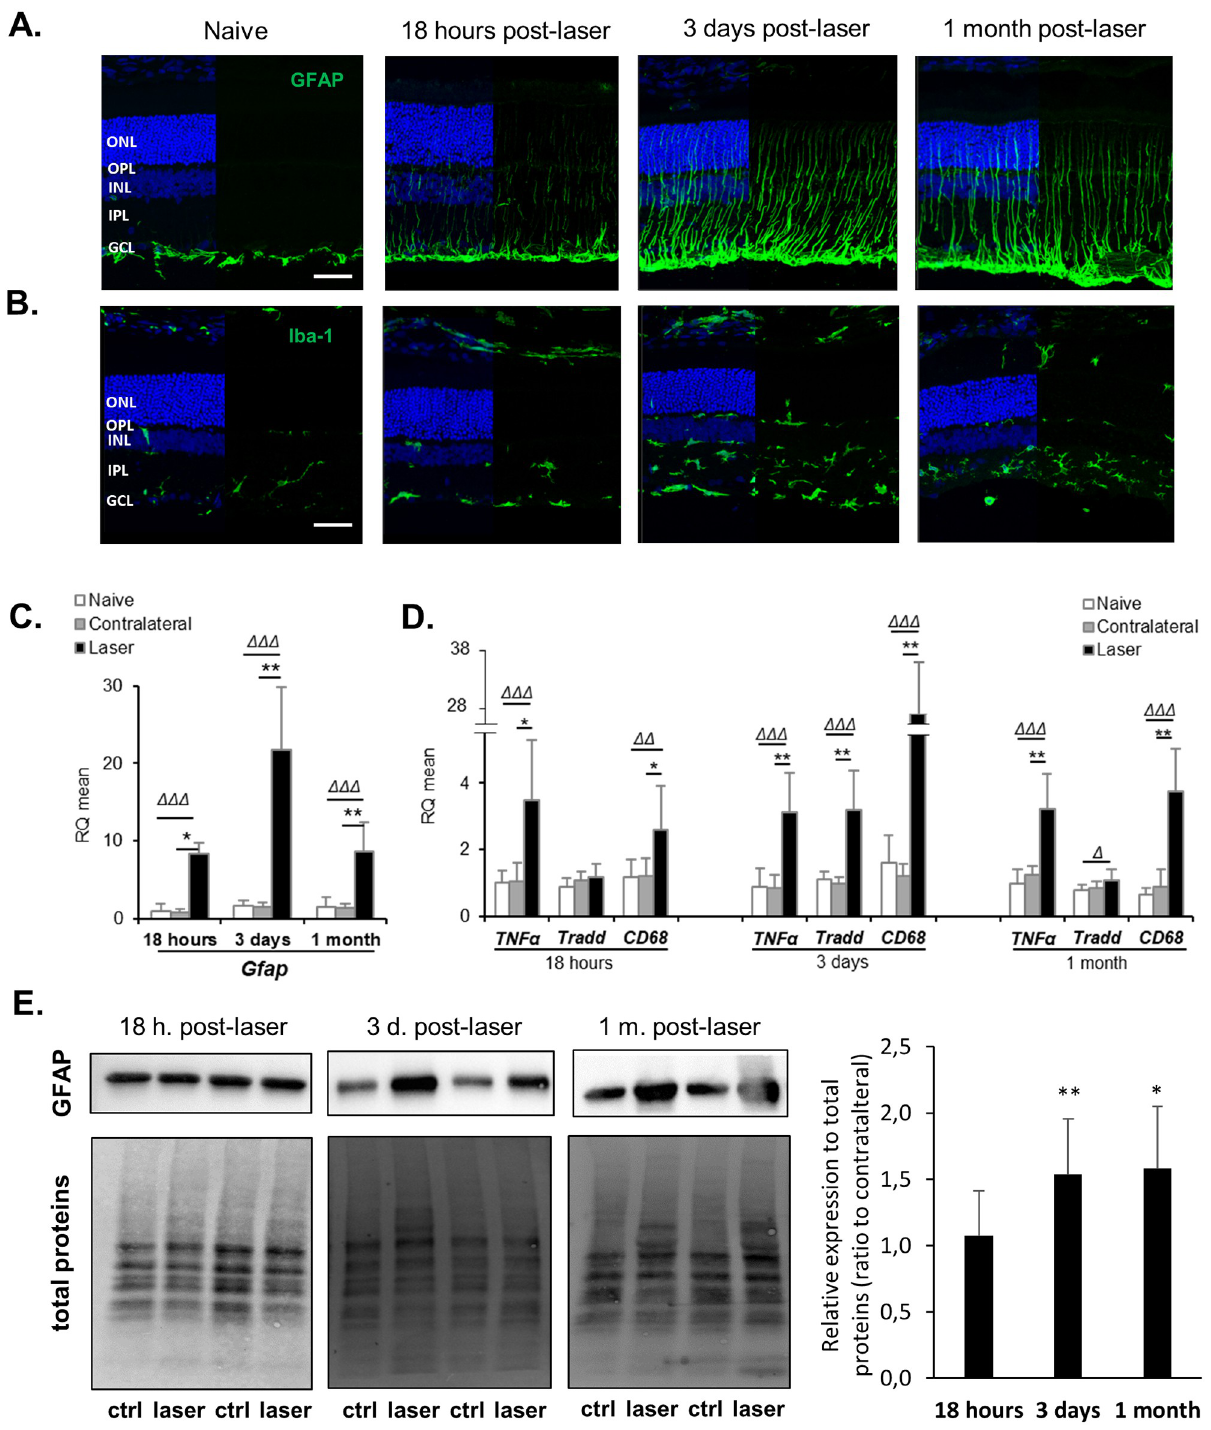
Fig 2. Laser procedure induces persistent gliosis and strong inflammation in the retina. Activation of macro and microglial cells was monitored by immunolabeling for GFAP (A) and Iba-1 (B) , respectively. Nuclei were stained with Dapi (blue). Scale bar: 50 μ m. ONL: Outer Nuclear Layer, OPL: Outer Plexiform Layer, INL: Inner Nuclear Layer, IPL: Inner Plexiform Layer, GCL: Ganglion Cell Layer. Images shown are representative of n = 6–8 retinas. (C, D) The expression of Gfap gene and genes related to inflammation was assessed using quantitative RT-PCR on retinas collected at 18 hours, 3 days or 1 month after laser photocoagulation. Data were analysed using the 2 - ΔΔ CT method. (E) The protein expression of GFAP (49 kDa) was measured by Western Blot. Results are presented as mean ± S.D, n = 6–8 retinas. Δ p < 0.05, ΔΔ p < 0.01, ΔΔΔ p < 0.001 vs naive (Mann-Whitney test), � p < 0.05, �� p < 0.01 vs contralateral (Wilcoxon matched-pairs signed rank test).